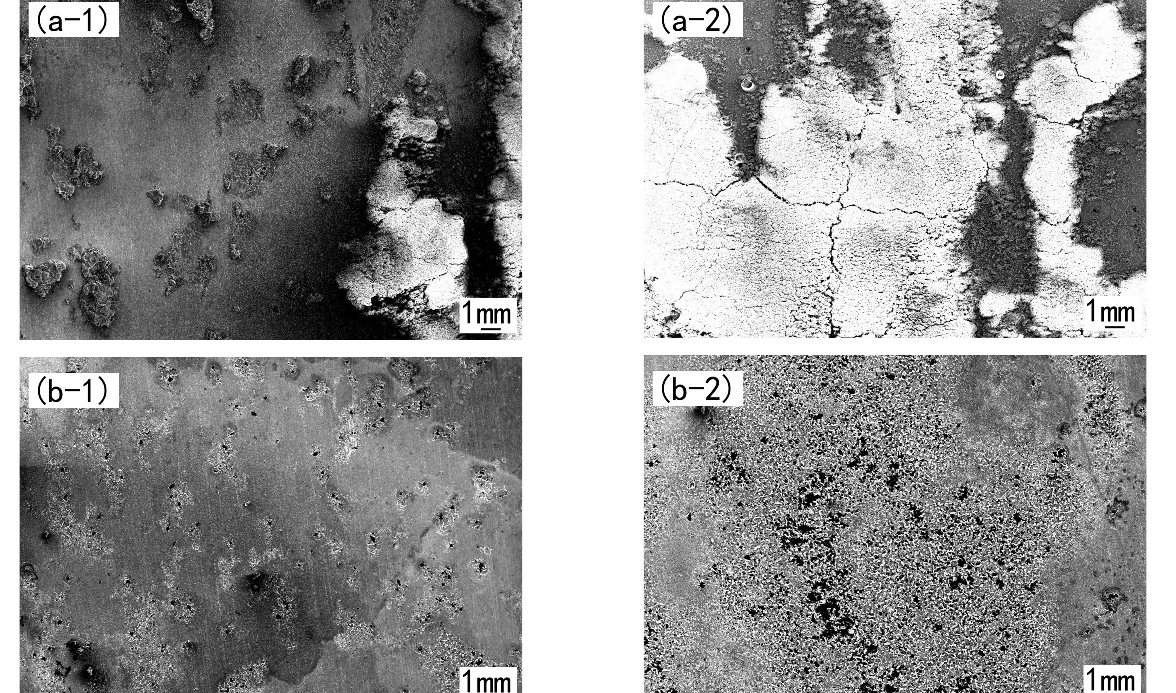
Figure 10. Surface topography of the pure corrosion test electrode: ( a ) before chemical cleaning, ( b ) after chemical cleaning.